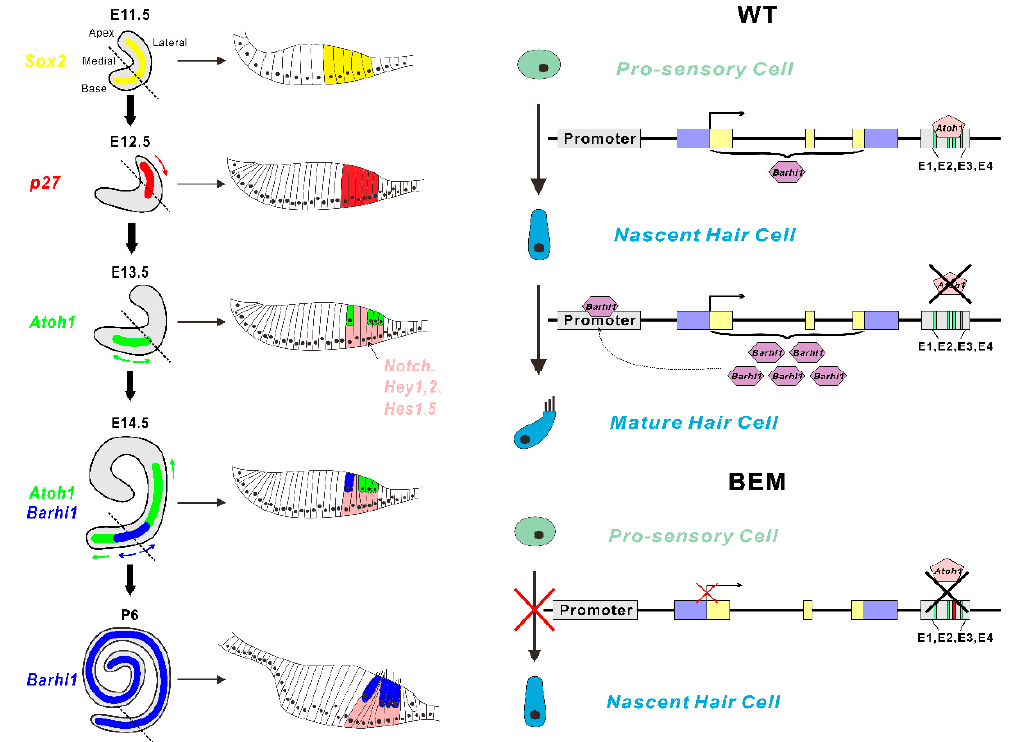
Figure 7. Atoh1-regulated Barhl1 expression during the organ of Corti development. Left panel: A concise outline of the cochlear development with cross sections at corresponding periods listed next to it. The cochlear duct commences with an expansion of the ventral part of the otocyst. A diagram of the entire cochlea at E11.5 highlights the expression of Sox2 (indicated by yellow) in the pro-sensory region. Several cyclin-dependent kinase inhibitors urge the pro-sensory cells to exit from cell cycles and this withdrawal originates from the apex and extends towards the base at E12.5. The gradient expression of p27 (indicated by red arrow) is consistent with the direction of cell cycle exit in the cochlea. Then the pro-sensory cells are guided into hair cell fate and supporting cell fate separately by Atoh1 and Notch signaling pathways. Atoh1 first expresses in the post mitotic pro-sensory region at E13.5, which signifies the beginning of hair cell di ff erentiation. Then Atoh1 expands its expression from the midbase to both the apex and base of the duct bidirectionally (indicated by green arrows). Notch, Hey1,2, and Hes1,5 (indicated by pink) direct pro-sensory cells to supporting cells. For the survival and maintenance of hair cells, multiple cell signaling pathways and genes are involved. Barhl1 first appears at E14.5 in the mid-base of cochlea and its expression pattern (indicated by blue arrows) follows that of Atoh1. At P6, Atoh1 expression ceases while Barhl1 expression continues to maintain the normal function of hair cells. Right panel: Schematics showing Atoh1 drives Barhl1 expression through the E3 site in the 3 (cid:48) enhancer. In the WT cell line, Atoh1 binds to the E3 site located at the 3 (cid:48) enhancer to activate Barhl1 expression, thereby driving the di ff erentiation of pro-sensory cells into nascent hair cells. When Atoh1 stops its expression at P6, Barhl1 can bind to the promoter region to maintain its own expression to form mature hair cells. However, in the BEM cell line, since Atoh1 cannot bind to the mutated E3 site in the 3 (cid:48) enhancer, the expression of Barhl1 failed to be activated, leading to the failure of nascent hair cell di ff erentiation from pro-sensory cells. Blue boxes, UTRs; yellow boxes, Barhl1 coding sequence (CDS); gray boxes, promoter and enhancer; black arrow, direction of